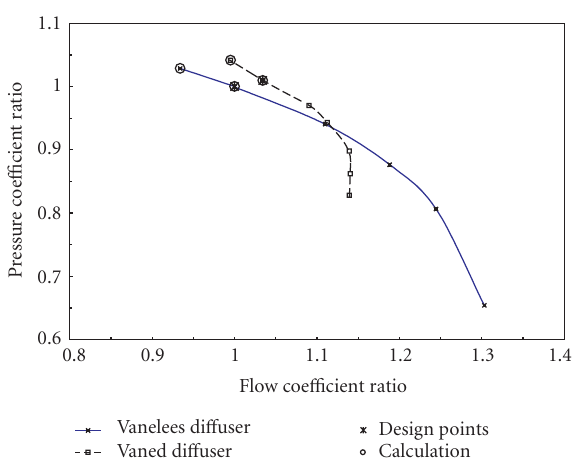
Figure 2: Pressure coe ffi cient of the